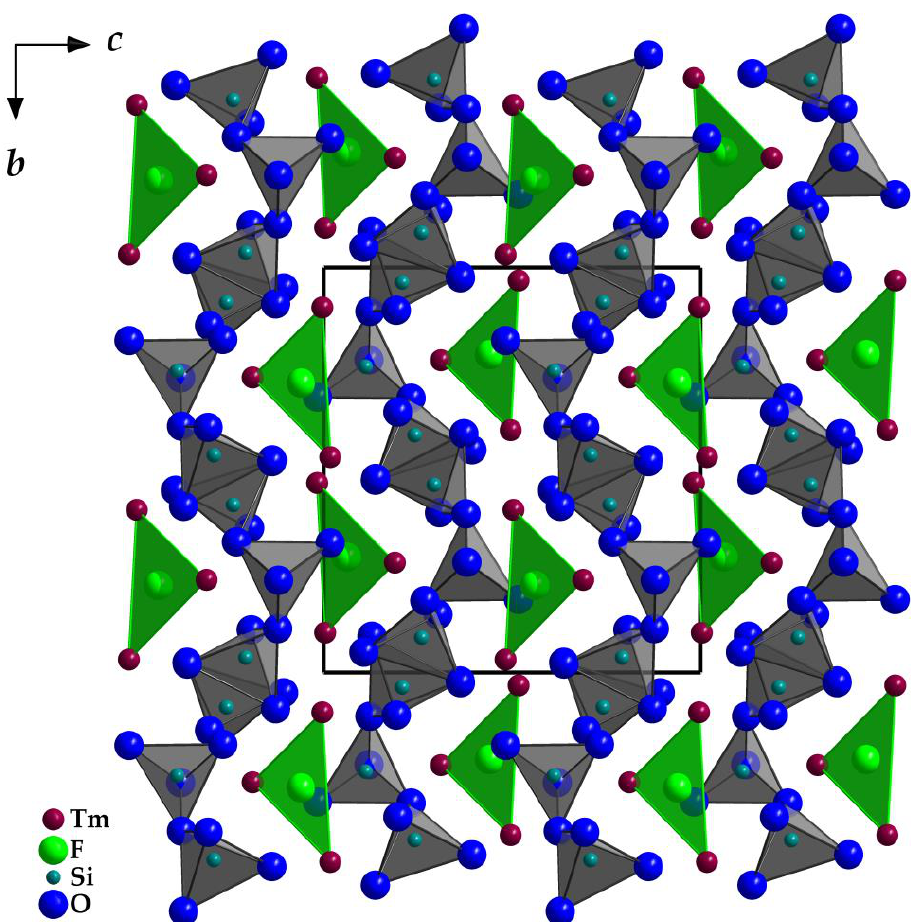
Figure 4. View at the monoclinic crystal structure of Tm 3 F[Si 3 O 10 ] along [100] emphasizing the discrete [FTm 3 ] 8+ and [Si 3 O 10 ] 8– units.